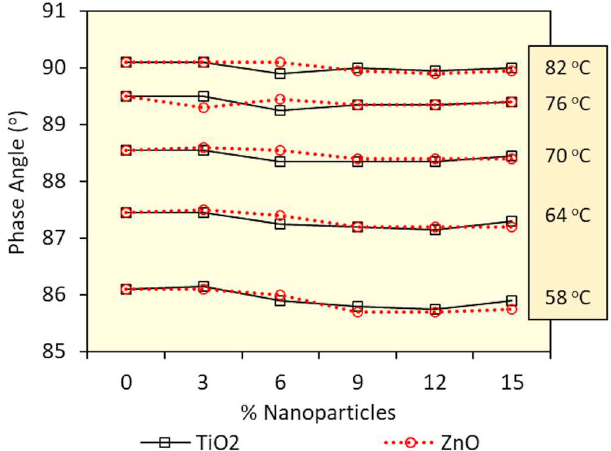
Figure 4. Comparison of the effect of the percentage of TiO 2 and ZnO on the phase angle ( δ ) of the conventional binder short-term aged at high temperatures (58 °C to 82 °C).